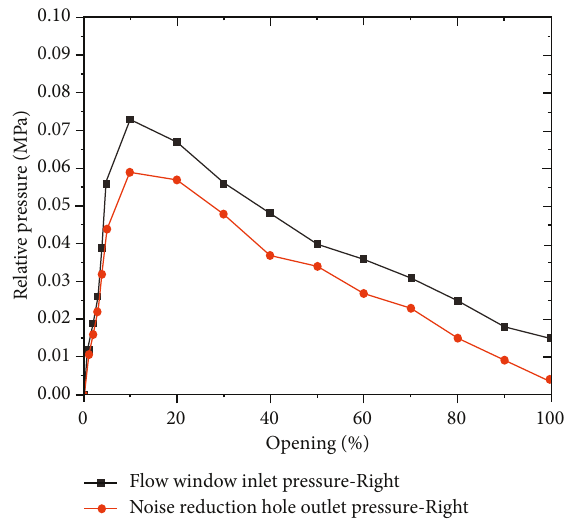
Figure 18: Right flow window noise reduction orifice inlet and outlet pressure-opening curve.